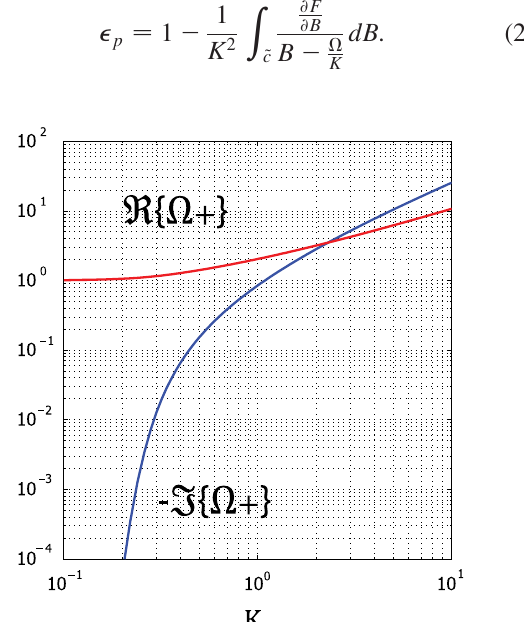
plane. The defor- FIG. 2. Real part (red line) and imaginary part (blue line) of x the roots of the plasma dielectric function for a transversely warm beam, as a function of the scaled wave number K